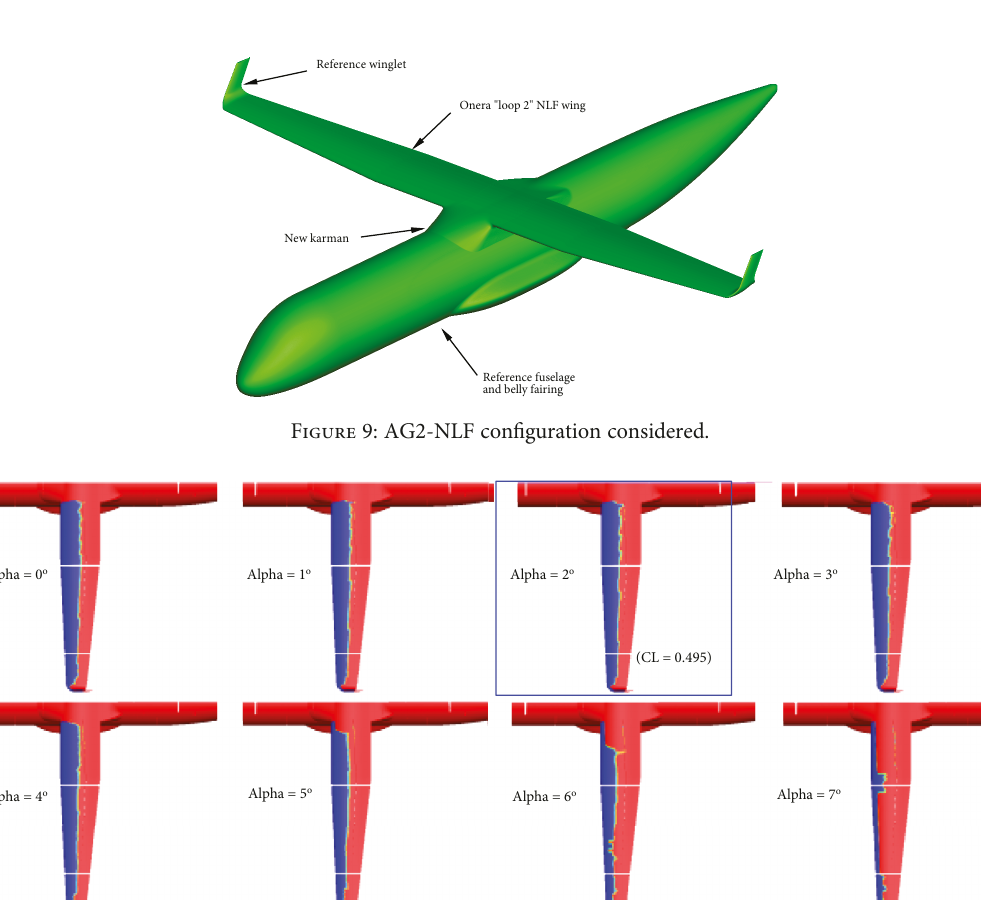
Figure 8: E ff ect of twist on the span loading distribution at cruise conditions ( M = 0 52 @ 20000 ft, CL = 0 50 ).